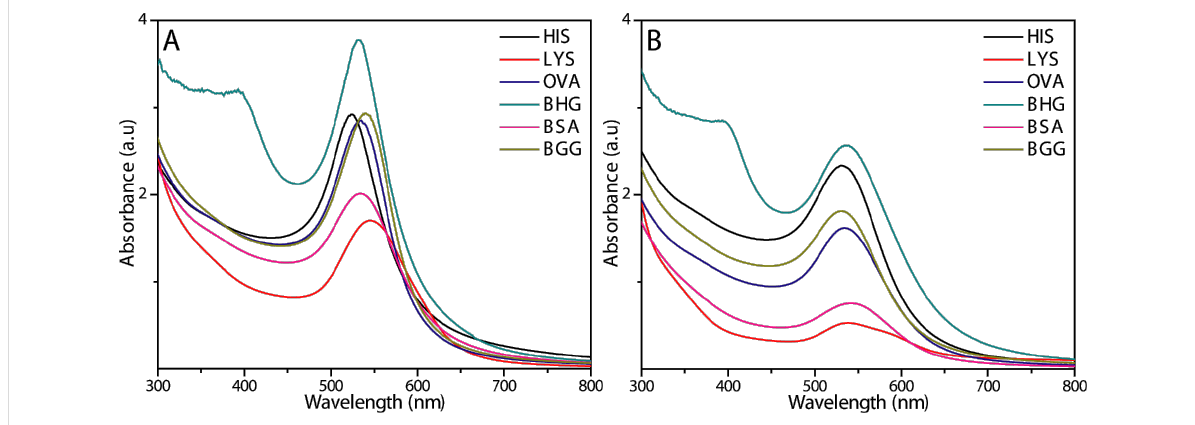
Figure 1: UV–vis spectra of the AuNPs (0.5 mM) prepared using different proteins (A) with and (B) without Ag ions at their intrinsic pH.